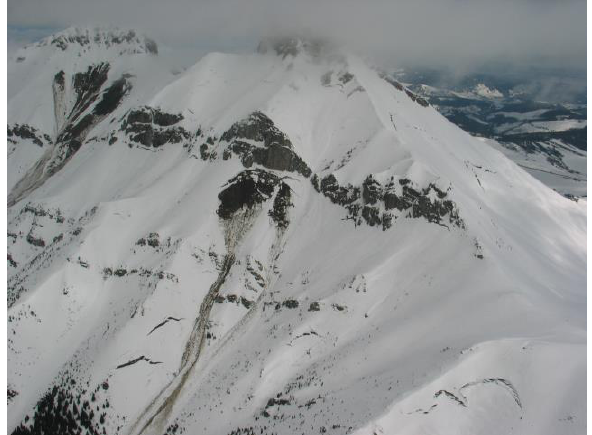
Figure 2: Avalanches in the area of the Belianske Tatry, photograph taken on April 1, 2009. Source: Slovakian Avalanche Prevention